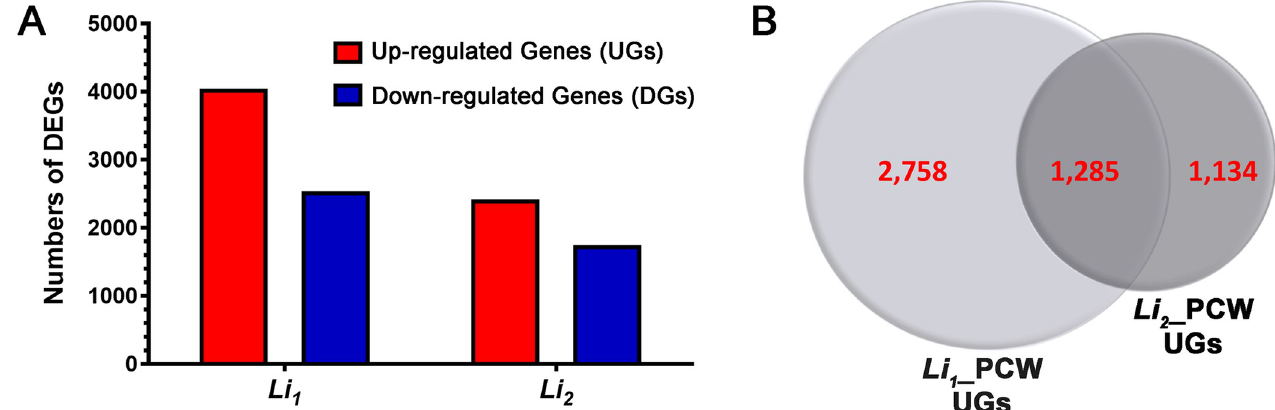
Fig 7. Transcriptomic analyses among three G . hirsutum NIL fibers differing in length. A. Summary of up- or down-regulated DEGs of G . hirsutum short fiber Li 1 and Li 2 mutant fibers at PCW stage with the corresponding NIL DP-5690 fiber. The DEGs annotated with JGI Gossypium raimondii reference genome were listed in S5 Table. B. Venn diagrams of the up-regulated genes (UGs) in developing G . hirsutum Li